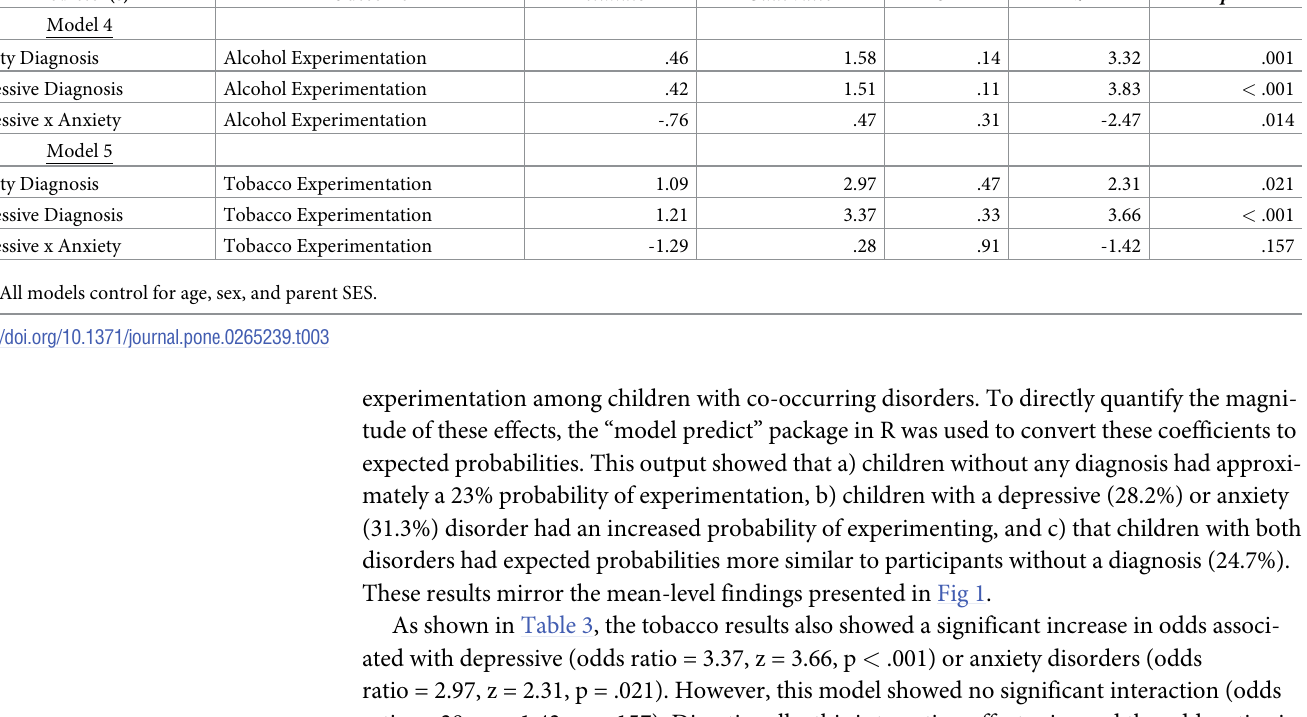
Table 3. Logistic regression follow-ups examining diagnostic status as a predictor of alcohol and tobacco experimentation separately.